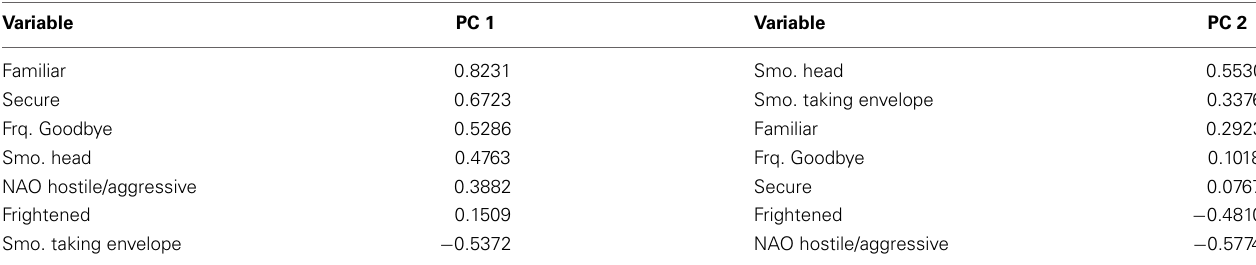
Table 4 | The two first principal components (PC) of the Principal Component Analysis (PCA) of the affective/emotional variables and the motion variables (Frq.: Frequency, Smo.: Smoothness) examined in our